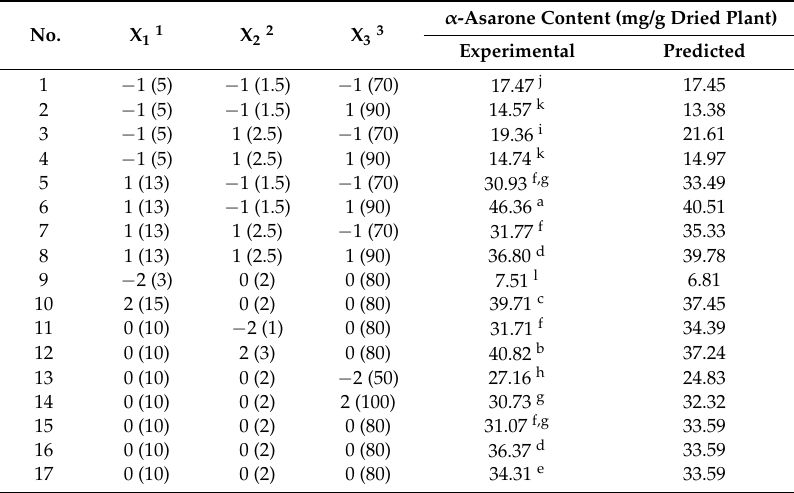
Table 3. Experimental range and values of the independent variables in the central composite design for optimization of extraction conditions.